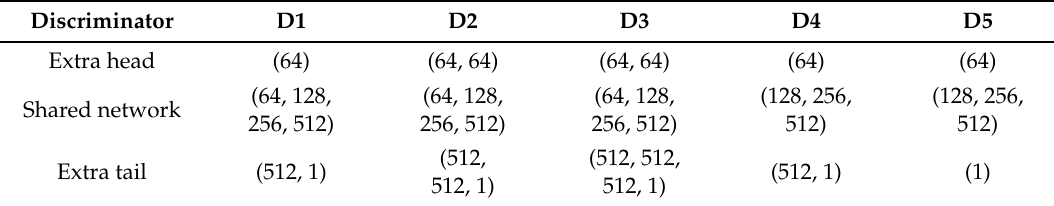
Figure 6. From ( left ) to ( right ): Input CT image, synthesized MR image with paired training, synthesized MR image with unpaired training, synthesized MR images with paired and unpaired training (ours), and the reference MR images. Table 2. Different network architectures for the discriminator.